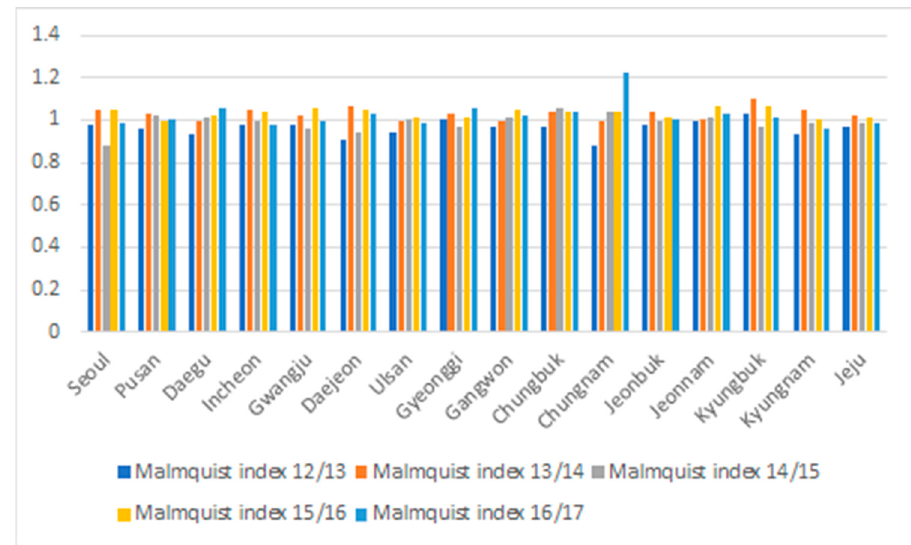
Figure 5. Productivity trend in local governments in 2012–2017.